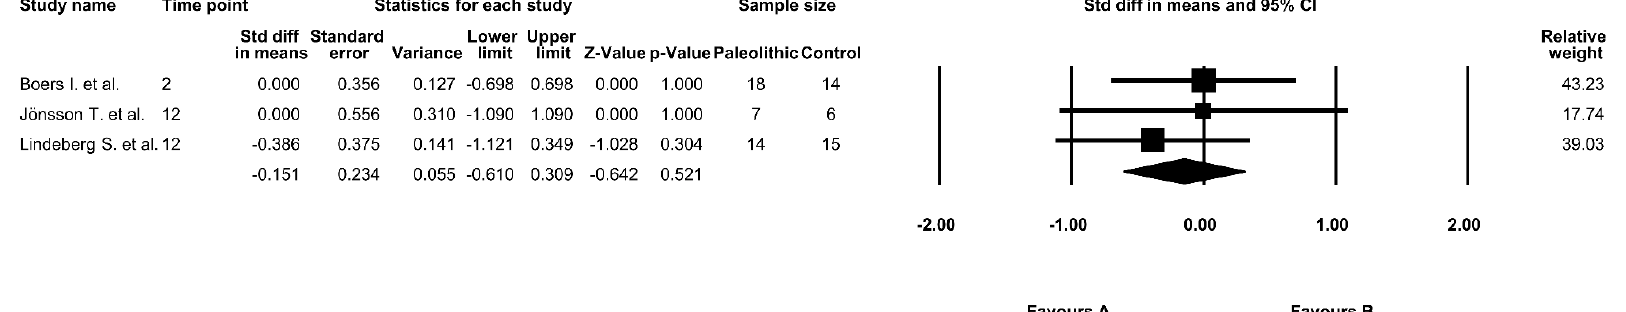
Figure 4. Forest plot comparing homeostasis model assessment of insulin resistance (HOMA-IR) between the diets (favors A—Paleo group; favors B—control group).